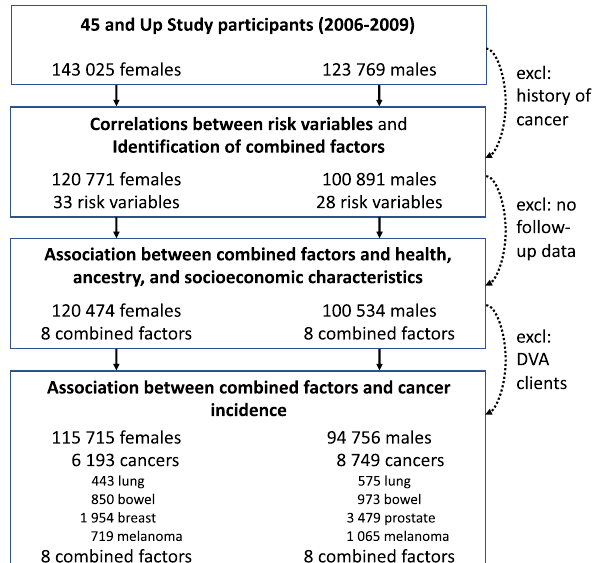
Figure 1. Overview of the study, included participants and incident cancers. excl excluded; DVA Australian Government Department of Veterans’ Affairs (clients excluded due to incomplete data